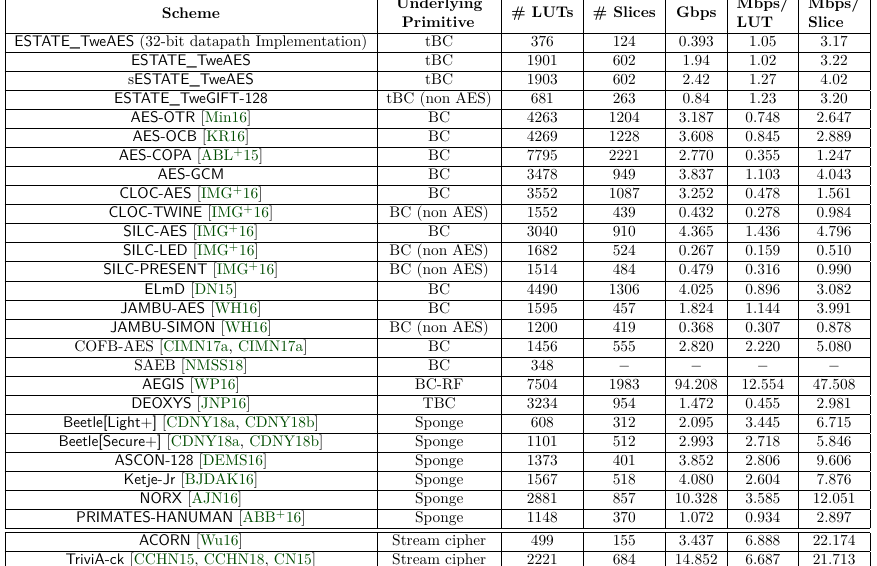
Table 11: Comparison on Virtex 7 with some of the implementation results in [ATHb]. Here BC denotes block cipher, SC denotes Stream cipher, (T)BC denotes (Tweakable) block cipher and BC-RF denotes the block cipher’s round function,‘-’ means that the data is not available Scheme Underlying Primitive # LUTs # Slices Gbps Mbps/ LUT Mbps/ Slice ESTATE_TweAES (32-bit datapath Implementation) tBC 376